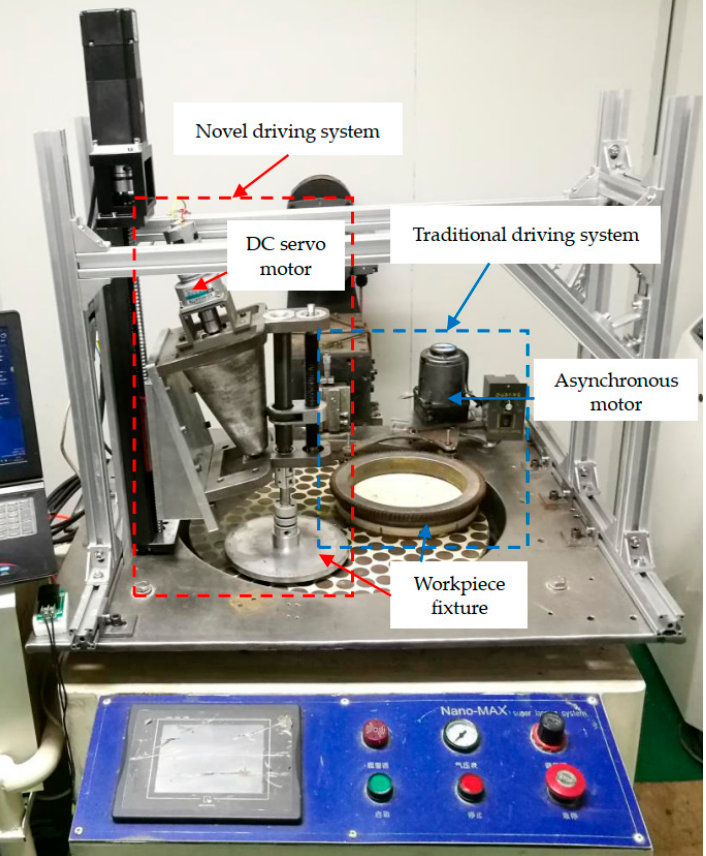
Figure 11. Experimental setup of the single-side planetary abrasive lapping test.